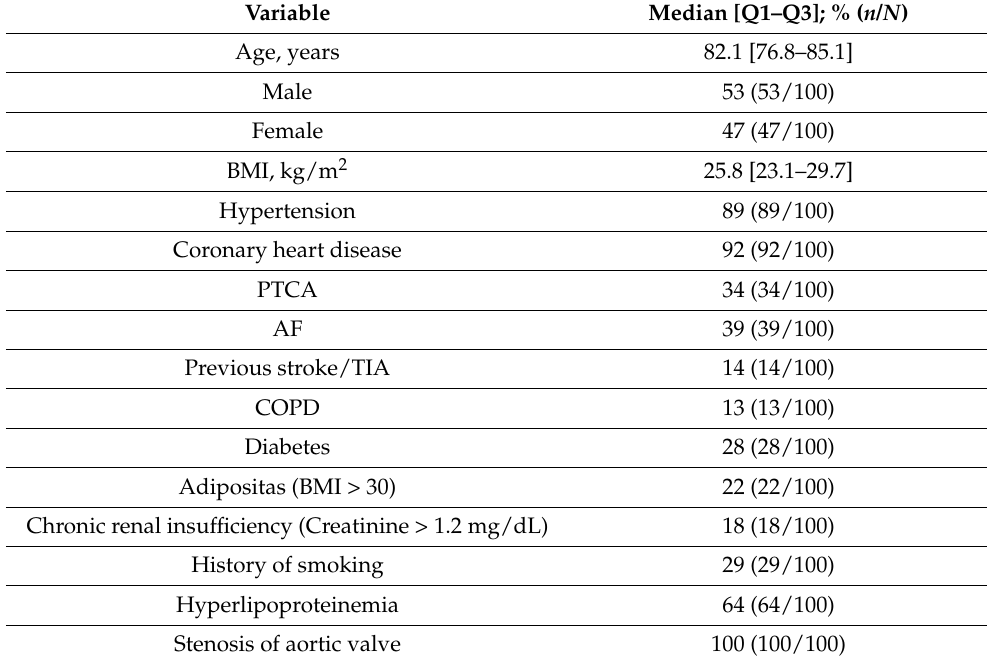
Table 1. Patient demographic data a .